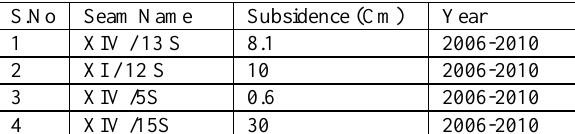
Table 1. Levelling Subsidence values from 2006-2010 for the different seam obtained from Central Institute of Mining and Fuel